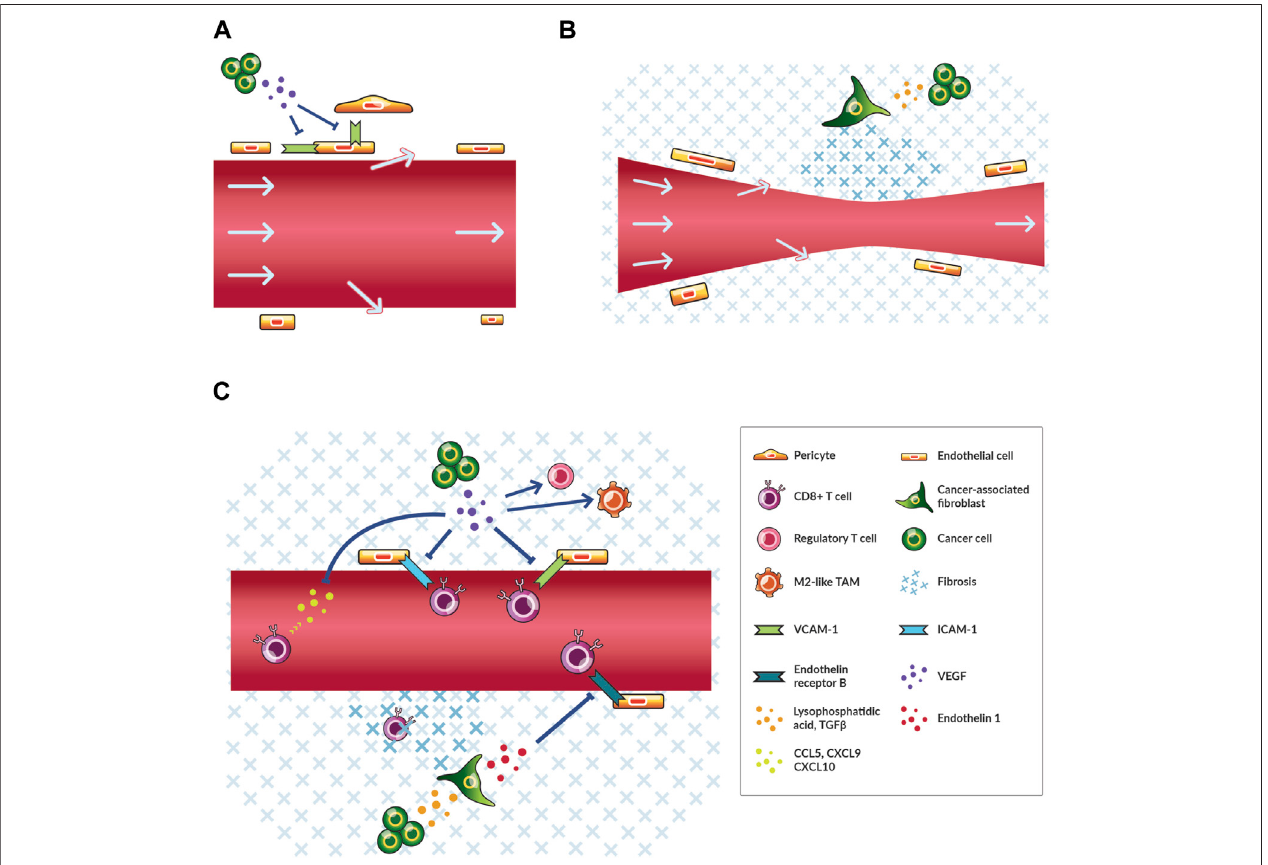
FIGURE 1 | Cancer cells contribute to angiogenesis, desmoplasia, and immunosuppression thereby reducing blood fl ow and immune cell in fi ltration. (A) A simpli fi ed schematic of leaky tumor blood vessels and relevant cells. Cancer cells secrete angiogenic factors, including vascular endothelial growth factor (VEGF), that reduce the expression of molecules, such as intercellular adhesion molecule 1 (ICAM-1), which facilitate the interaction of endothelial cells with themselves and perivascular cells in normally functioning vessels. Plasma and blood-borne molecules (arrows) fl ow out of pores in the vessel wall thereby reducing fl ow. (B) A simpli fi ed schematic of compressed tumor blood vessels and relevant cells. Cancer cells activate cancer-associated fi broblasts through various signals including transforminggrowthfactor(TGF) β .Asaresult,more fi brosisisproducedandmaintainedtherebytransferringcompressivephysicalforceontobloodvessels.Blood fl ow is reduced. (C) A simpli fi ed schematic of immunosuppression and relevant cells. As in (A) and (B) , cancer cells secrete VEGF and TGF β among other factors that affect angiogenesis and fi brosis. VEGF recruits regulatory T cells and shifts tumor-associated macrophages (TAMs) towards M2-like immunosuppressive phenotypes. VEGF also blockstherecruitmentand transmigration ofCD8 + Tcells. TGF β signalingleadstoincreased fi brosisthatphysically impedes themigrationofCD8 + Tcellstocancer cells and blocks the vascular transmigration of these cells through endothelin one signaling through the endothelin receptor type (B)